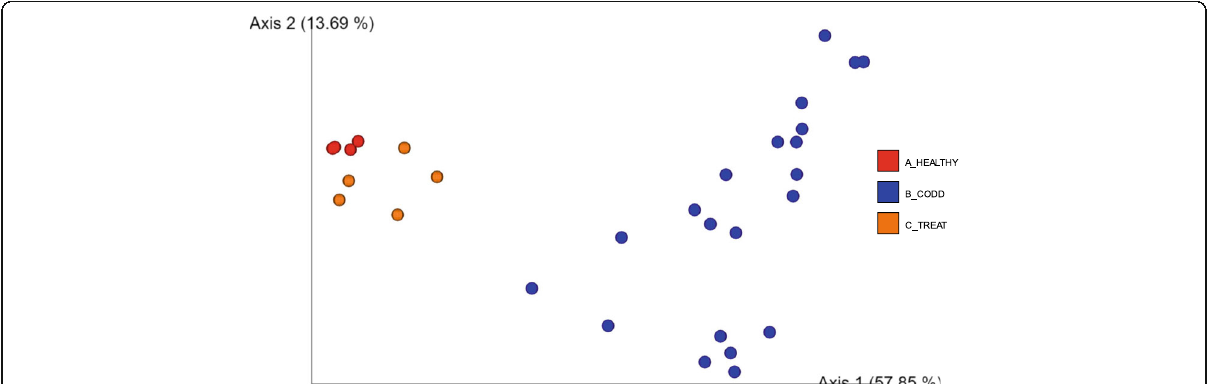
Fig. 8 Principle Coordinate Analysis (PCoA) plot showing differences in weighted UniFrac differences of samples from healthy (A_Healthy), CODD affected (B_CODD), antibiotic treated (C_Treated) sheep ’ s feet. ANOSIM tests show beta diversity was significantly different overall three states (R test statistic 0.825846, p = 0.001), Pairwise ANOSIM tests between microbiota at each lesion type (A_Healthy, B_CODD, C_Treated ( p <